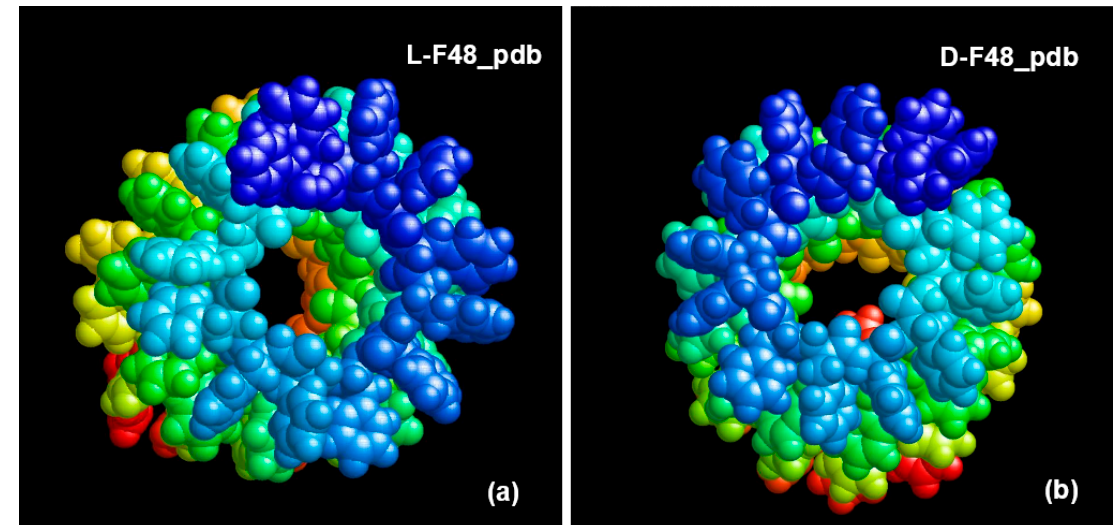
Figure 6. The obtained results of MDS and self-assembly of phenylalanine helical-like nanostructures: ( a ) L-F48_pdb; ( b ) D-F48_pdb (images were obtained from *.pdb files using the RasMol program http://www.openrasmol.org/ (accessed on 30 September 2021)). We transferred dipole moments to the HyperChem [105] workspace (in *.hin format with Cartesian x, y, z coordinates for all atoms) for analysis (Figure 7).